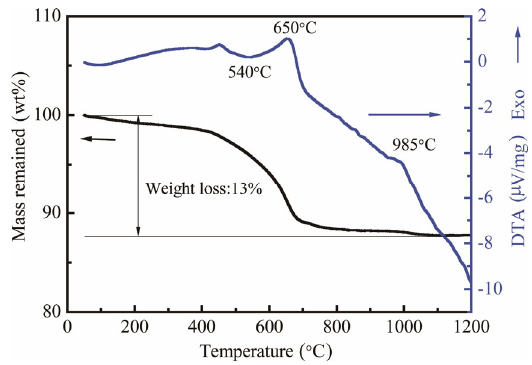
Fig. 3 TG/DTA curves of green coal gangue microspheres in air atmosphere with heating rate of 10 /min up to 1200 ℃ ℃